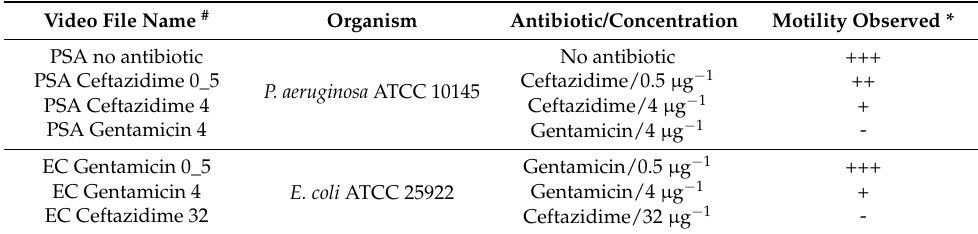
Table 1. Summary of motility observed in video recordings of microcapillaries with a range of antibiotic/bacteria